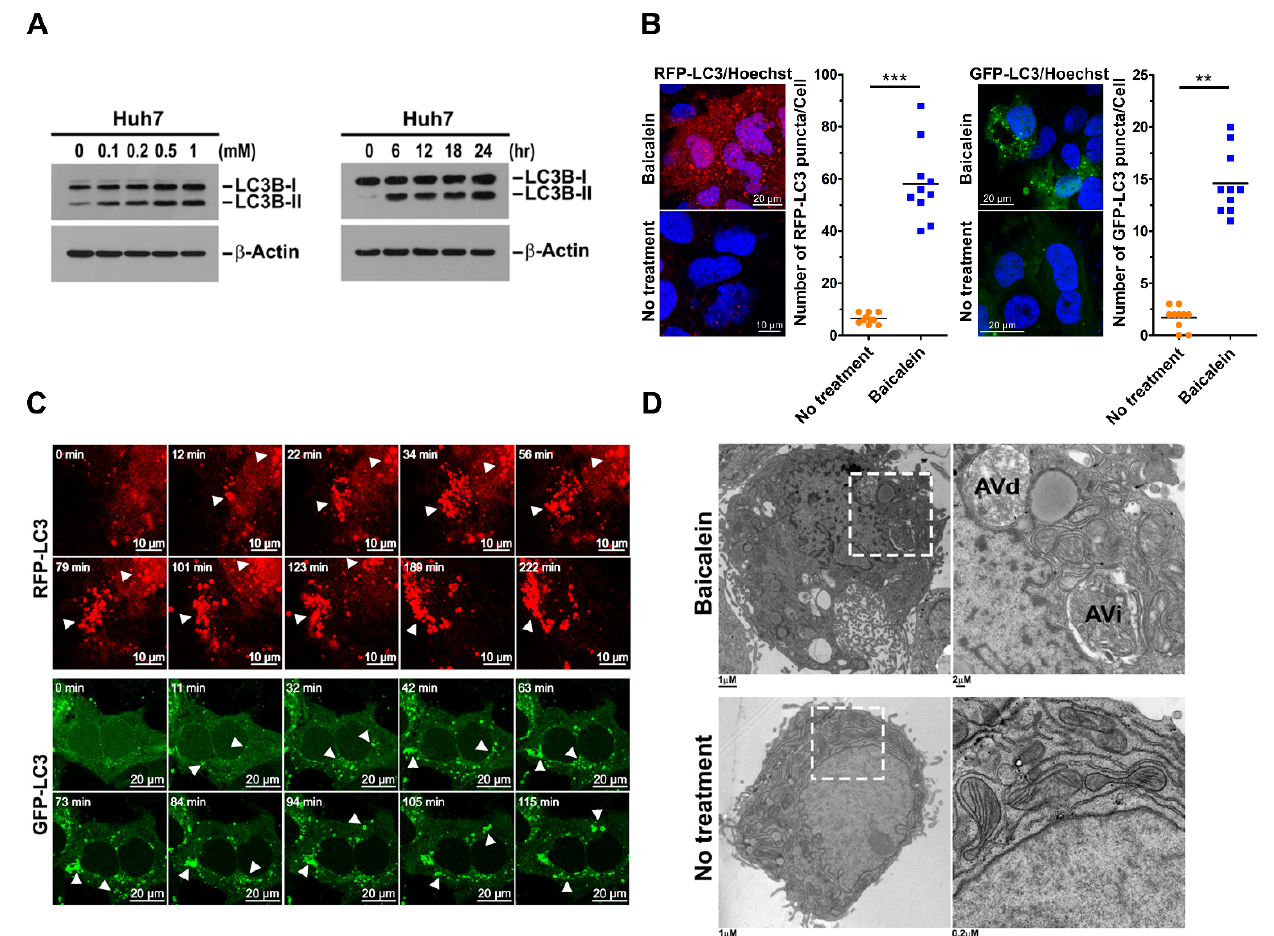
Figure 1. Formation of autophagic vacuoles induced by baicalein: ( A ) Left panel: Huh7 cells were treated with baicalein at the indicated concentrations. Twelve hours later, the cells were harvested and analyzed for protein expression by Western blotting. Right panel: Huh7 cells were treated with 0.5 mM baicalein and harvested at different times for use in the Western blot analysis. β -Actin was immunoblotted as the internal control used to ensure that equal amounts of protein in each sample were loaded. ( B ) Huh7 cells stably expressing RFP-LC3 and GFP-LC3 (Huh7/RFP-LC3 and Huh7/GFP-LC3 cells, respectively) were established by lentiviral gene delivery as described in “Ma- terials and Methods”. Huh7/RFP-LC3 (left panel) and Huh7/GFP-LC3 cells (right panel) were treated with 0.5 mM baicalein for four hours and analyzed by confocal microscopy. Hoechst 33342 staining (blue) indicates the loci of nuclei. The number of RFP-LC3 and GFP-LC3 puncta was quan- tified. The data represent the means ± SEM ( n = 10, *** p < 0.001, ** p < 0.01). ( C ) Selected live imaging frames showing Huh7/RFP-LC3 and Huh7/GFP-LC3 cells treated with 0.5 mM baicalein. RFP-LC3- and GFP-LC3-labeled autophagic vacuoles are shown by white arrowheads. Movies of the live im- aging are presented in Supplemental Videos S1 and S2. ( D ) The baicalein-treated Huh7 cells de- scribed in ( C ) were analyzed by TEM. The right panel shows the enlargement of the white dashed boxes presented in the left panels. AVi, initial-stage autophagic vacuole; AVd, late-stage and deg- radative autophagic vacuole. 3.2. Baicalein Activates Complete Autophagy throughout Autolysosome Maturation To verify whether baicalein-induced autophagy proceeds to autophagosome–lyso- some fusion, we analyzed the colocalization of autophagic vacuoles and lysosomes in bai- calein-treated cells. As shown in Figure 2A, we found that baicalein treatment induced dramatic colocalization of LAMP1, a lysosome-associated protein with RFP-LC3-labeled autophagic vacuoles, compared with that in untreated cells, in which no significant over-